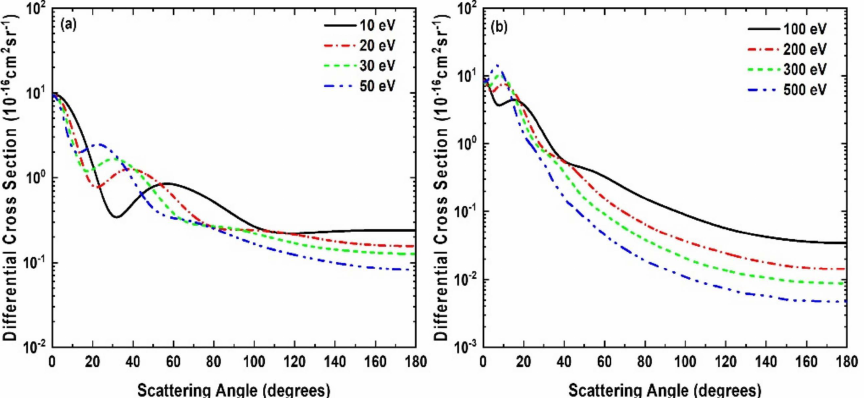
Figure 8. Differential cross sections for positron-SiH 4 elastic scattering at incident positron energies ( a ) 10–50 eV and ( b ) 100–500